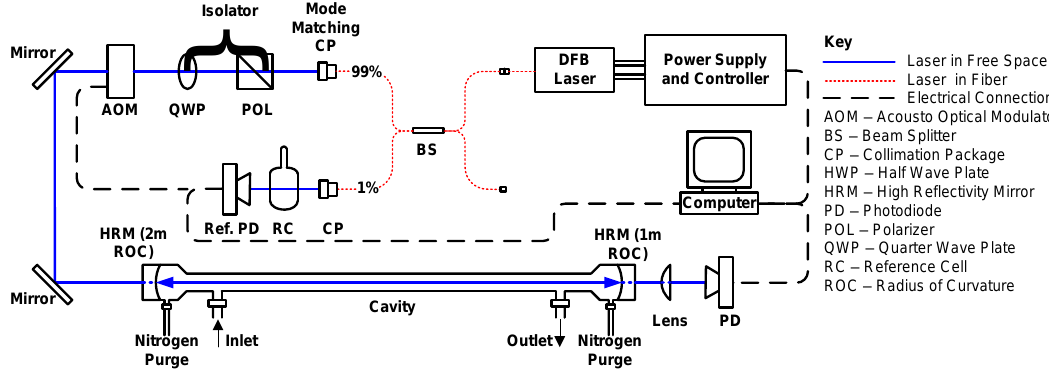
Fig. 3. Schematic of the optical components and data acquisition systems of the HCl sensor. The reference cell is used during normal operation, and is replaced with the Fabry–Perot etalon only during frequency calibration.